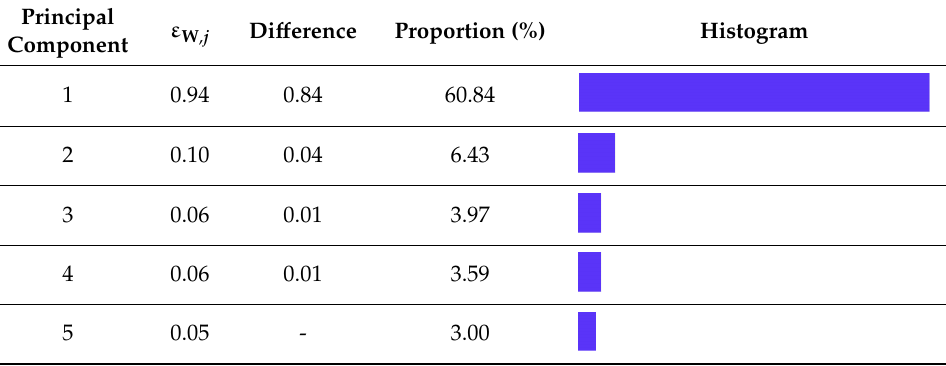
Table 4. The first five ε W, j obtained by VBPCA algorithm for the up component.